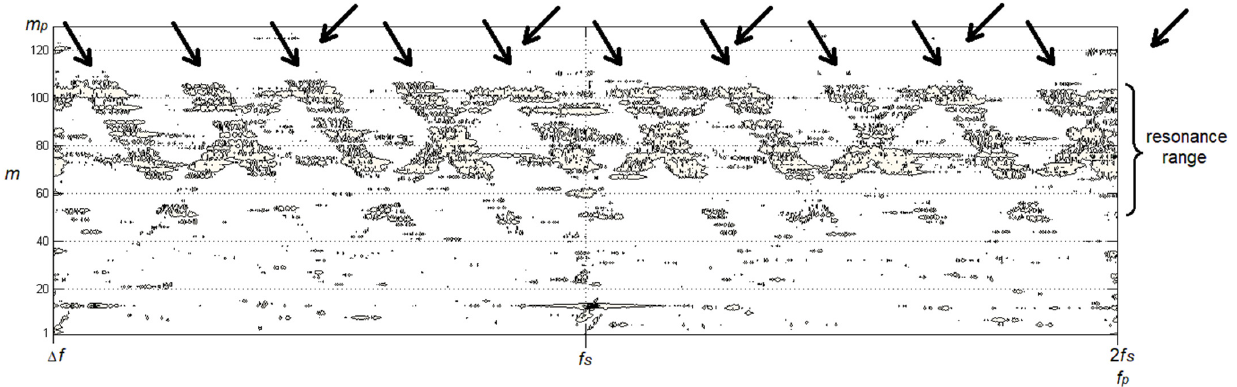
Figure 7. F-F image of the frequency spectrum of the vibration acceleration of the motor’s outer casing with a damaged bearing cage ( f P = 2 f s ). The positions of the new diagonal patterns are marked with arrows.